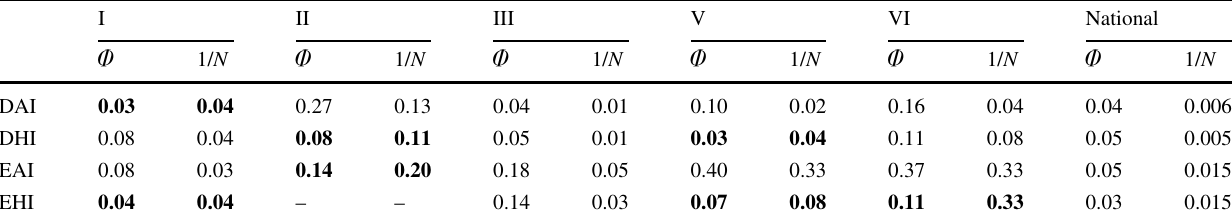
Table 3 Effectiveness of risk pooling in each agricultural zone for